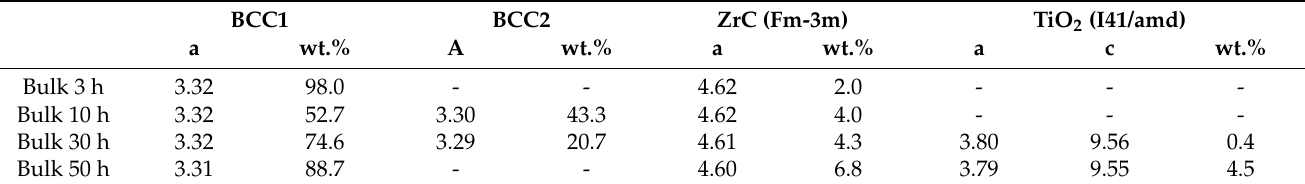
Table 2. Lattice parameters of the sintered bulks utilizing powders with different times of milling. BCC1